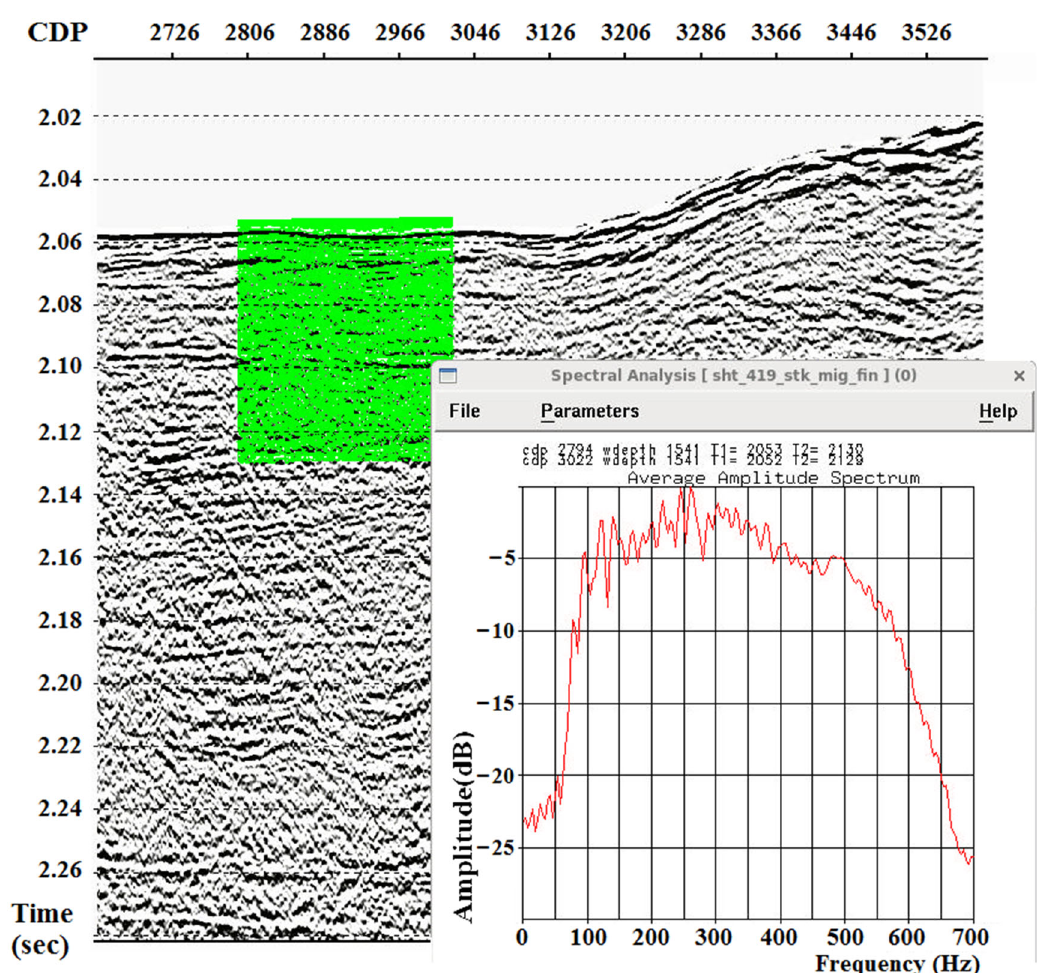
Figure 8. Spectrum scanning diagram of a single shot.